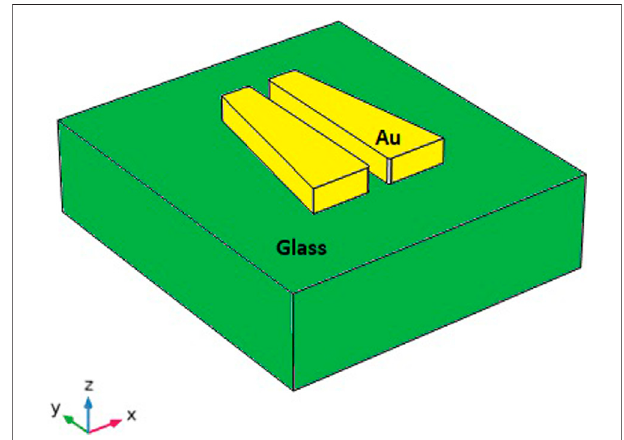
FIGURE9| Sketchoftheasymmetricaltrapezoidalplasmonicstructure. Adapted from Jiao et al. (2016)